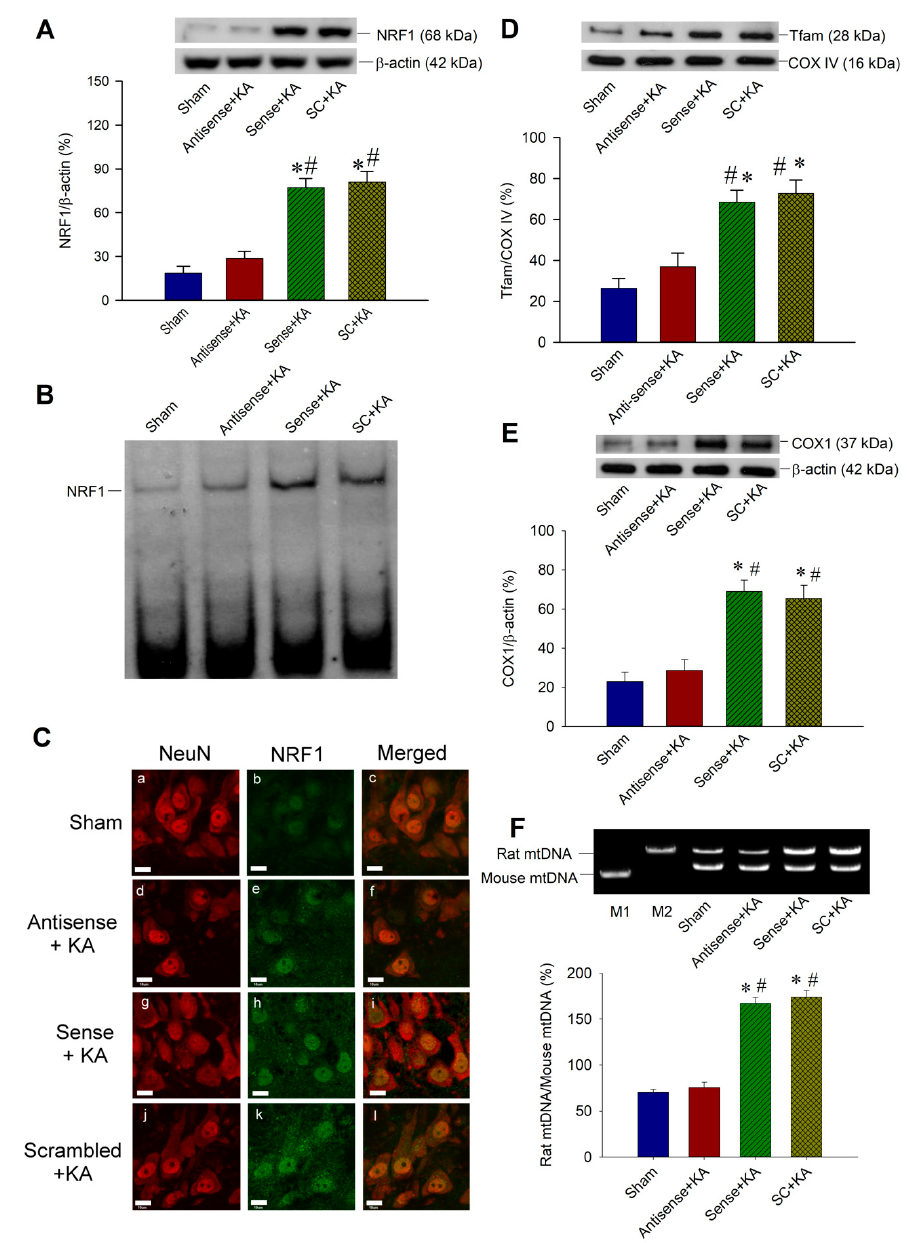
Figure 4. Effects of antisense ODNs against Sirt1 on mitochondrial biogenesis in kainic acid (KA)-induced status epilepticus in the hippocampal CA3 subfield. ( A ) Representative gels (inset) or changes in nuclear respiratory factor 1 (NRF1) relative to β -actin protein, detected in samples collected from the right CA3 subfield of the hippocampus in sham-control animals, or 6 h after the microinjection of KA (0.5 nmoL) into the left hippocampal CA3 subfield in animals received 24 h before pre-treatment with application into the bilateral CA3 subfield of antisense, sense, or scrambled (SC) ODNs against Sirt1 (1 nmol). Antisense ODNs against Sirt1 decreased seizure-induced NRF1 expression after 6 h following status epilepticus. ( B ) In accordance with NRF1 protein expression, the DNA-binding activity of NRF1 also decreased with Sirt1 antisense ODNs. ( C ) Laser scanning confocal microscopic images of a representative cell in the right CA3b subfield of the hippocampus that was immunoreactive to a neuronal marker, NeuN (red fluorescence), and additionally stained for NRF1 (green fluorescence)